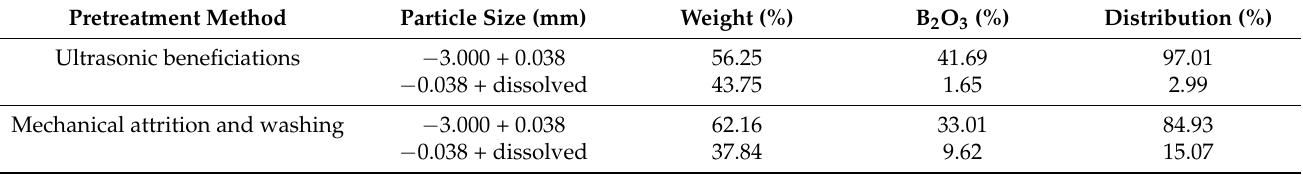
Table 2. Comparison between ultrasonic beneficiation and mechanical attrition and washing methods [20].